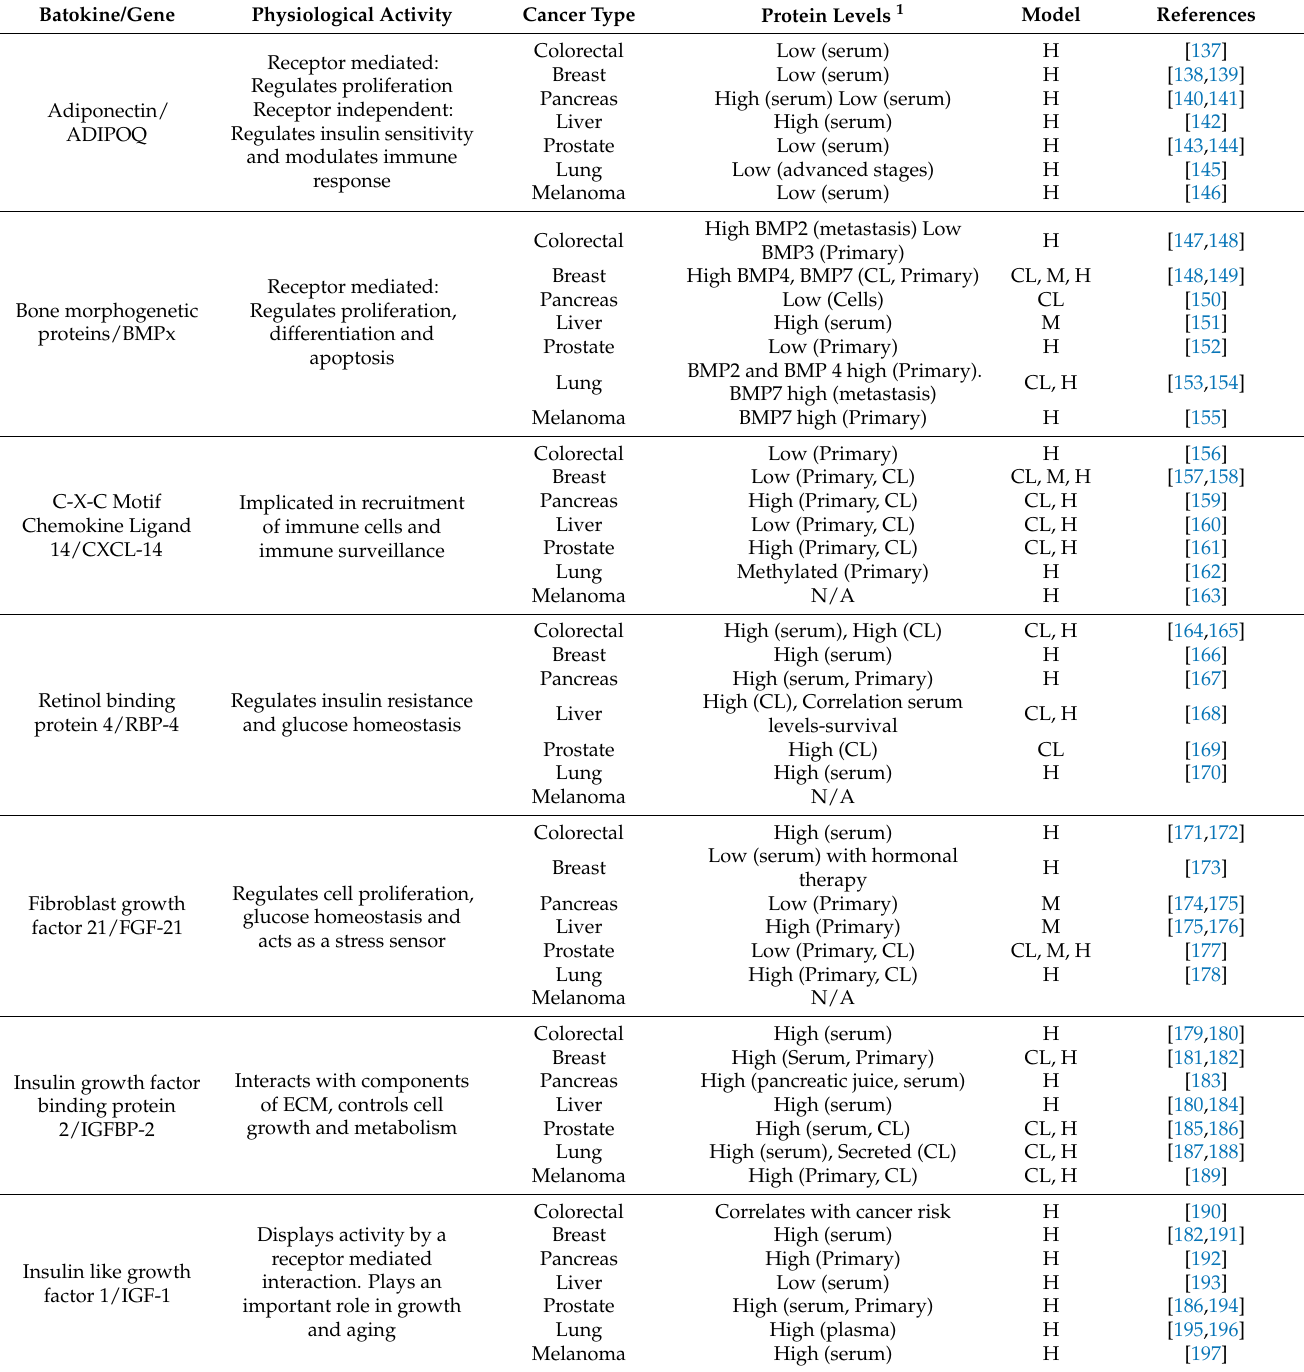
Table 2. Common reported levels of “batokines” in solid